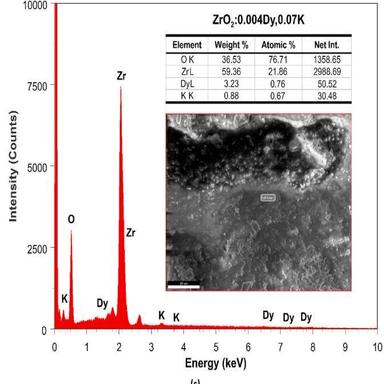
EDS spectra with elemental composition of (a) ZrO2 (b) ZrO2:Dy3+ (c) ZrO2:Dy3+,K+.